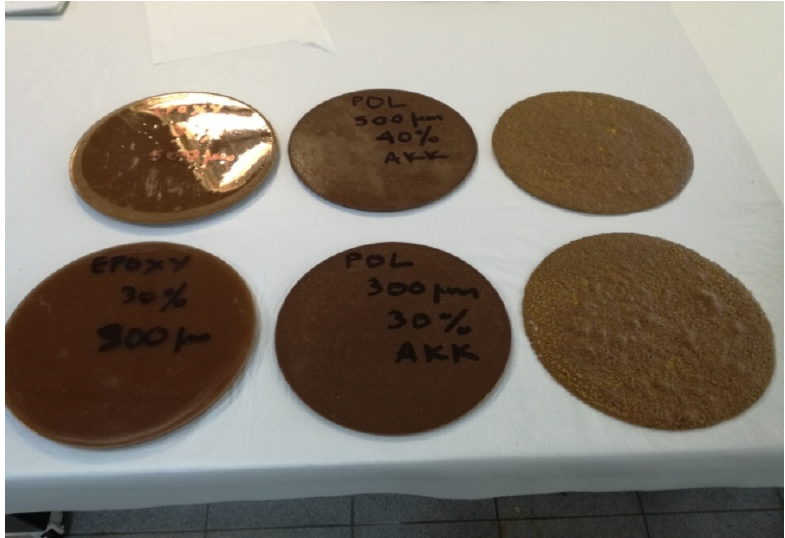
Figure 3. Composite specimens for thermal insulation efficiency testing [From left to right Epoxy Resin Composites (ERC), Unsaturated Polyester Composites (UPC), and Novolac Composites (NC) specimens].